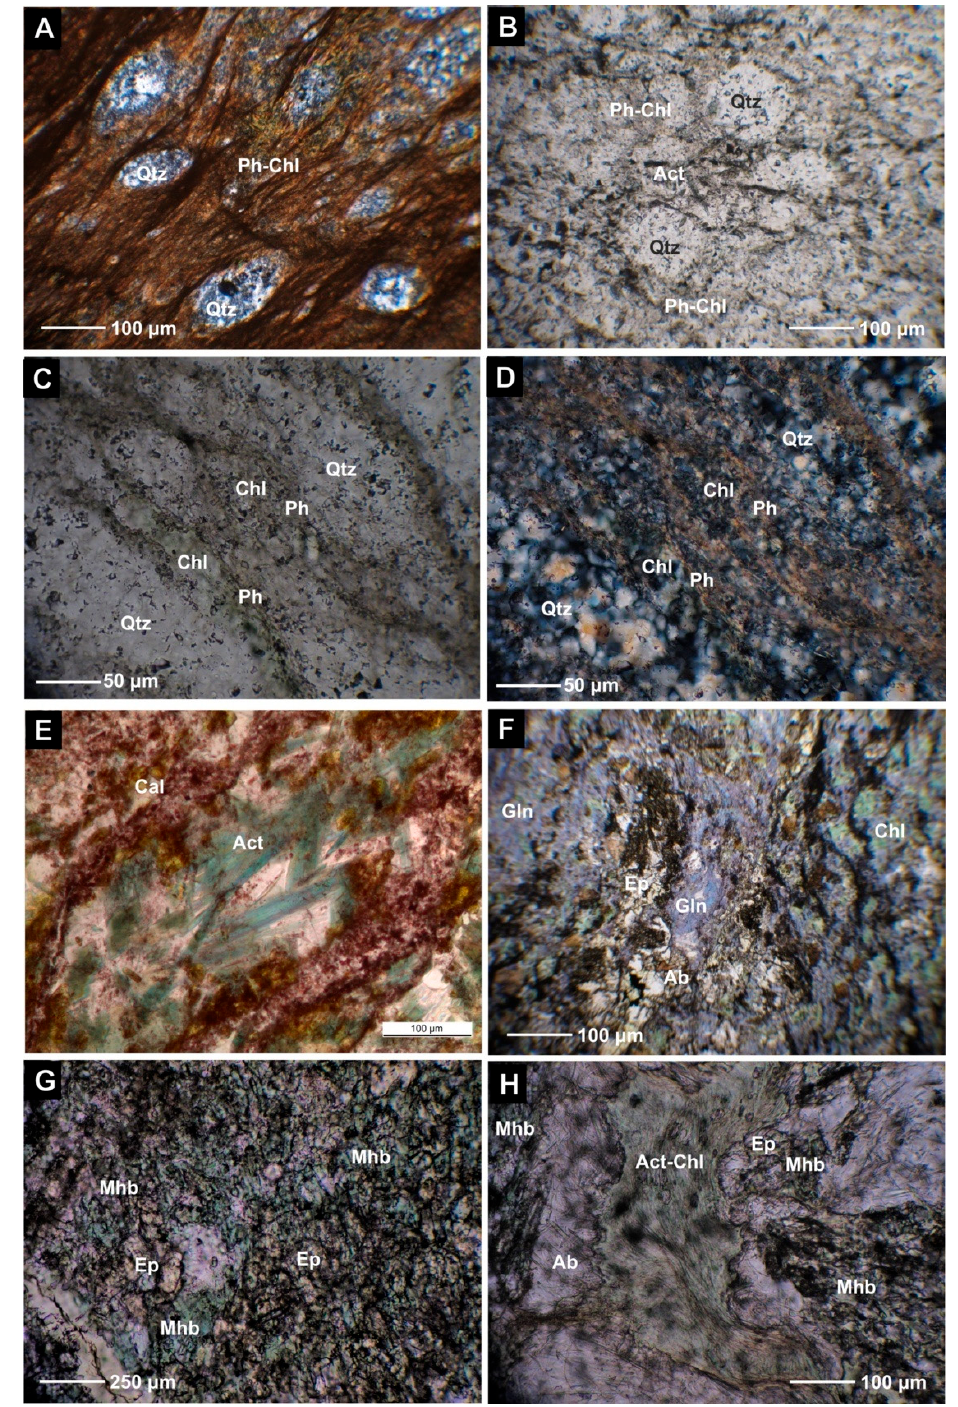
Figure 8. Metamorphic textures of the Jaklovce Unit rocks: ( A – D ) impure metaradiolarites (s. JAK-6/19 in A, and s. DO-K2 in B–D) with newly formed Qtz, Chl, Ph, ±Act; ( E ) a reddish cherty metacarbonate layer with blue-green Act after basaltic tuff admixture (s. JAK-2/1); ( F ) blueschist (s. MR-1) facies metabasalt with blue Gln, Chl, Ep and Ab; and ( G , H ) Mhb amphibolite (s. BRT-1) is crosscut by an Act–Chl–Cal–Ab veinlet. Pictures B, C and E–H at II N; A and D at X N.